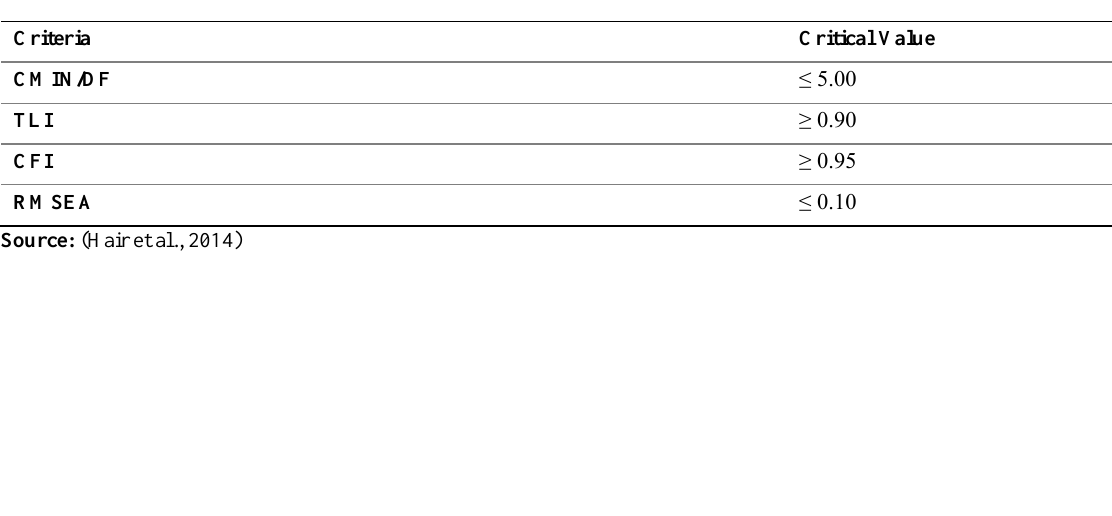
Table 1: Goodness of Fit